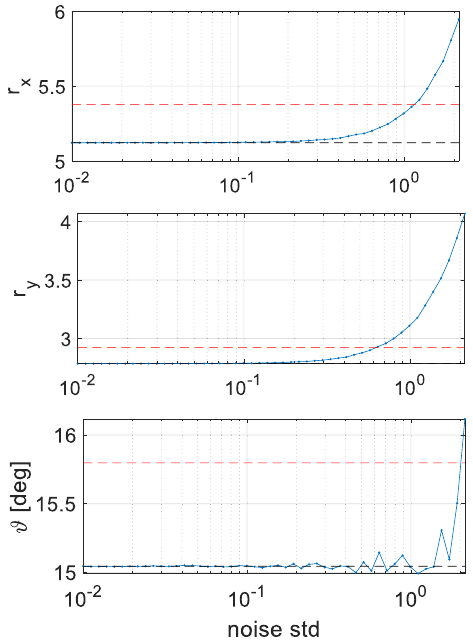
Fig. 9. Monte Carlo repetition for noisy elliptic orbit: PCA estimated r x , r y and # Vs random normal noise standard deviation. In red, a 5% threshold for the estimation error.